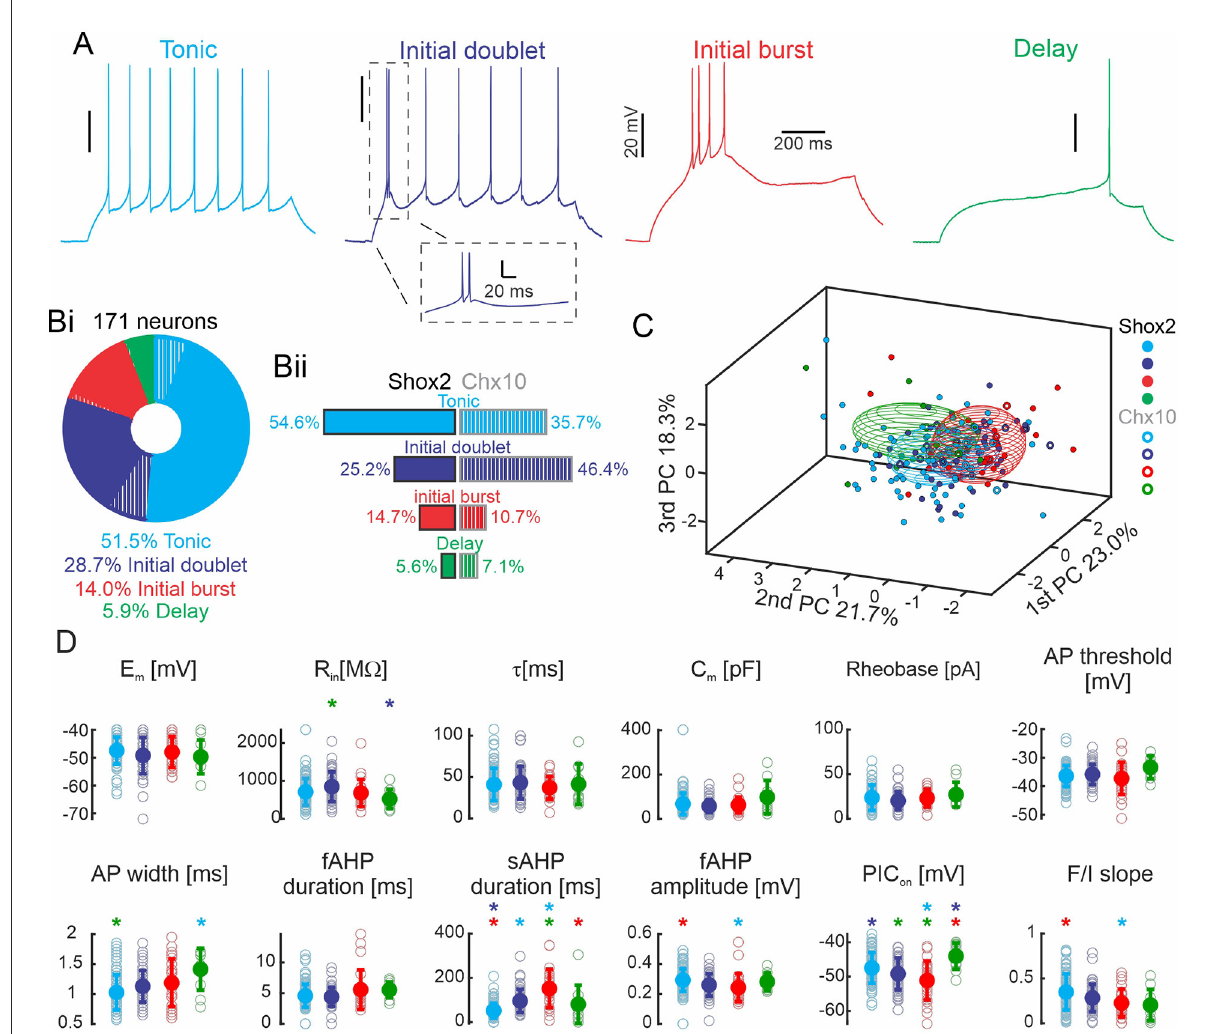
FIGURE4 Shox2 and Chx10 neurons sorted based on type of firing. (A) Representative traces of the four action potential firing types in response to the injection of a 1-s depolarizing current step. (Bi) Pie chart and incidence of the four types of firing responses observed in all 171 neurons. 83.6% of the neurons were Shox2 neurons (solid) and 16.4% were Chx10 neurons (hatched). (Bii) Incidence of the four firing types observed in 143 Shox2 neurons (left) and in 28 Chx10 neurons (right). (C) Three-dimensional representation of all neurons (Shox2 filled dots, Chx10 unfilled dots) on the three principal component axes (same as Figure 2B, but different angle displayed). Ellipsoids are centered on the mean for the three first PCs and semi-axes are generated by the standard deviation of each of the three first PCs. Cyan, blue, red, and green ellipsoids represent tonic, initial doublet, initial burst, and delay firing subgroups, respectively. (D) Comparisons of electrophysiological properties of tonic, initial doublet, initial burst and delay firing neurons. Colors as in other panels. Filled circles represent the mean and error bars the standard deviation, unfilled gray circles represent individual neurons. Properties as in Figure 3. * p < 0.05, one-way ANOVA with Tukey post-hoc test or Kruskal-Wallis with Dunn’s post-hoc test. * significantly different from the corresponding color coded group.